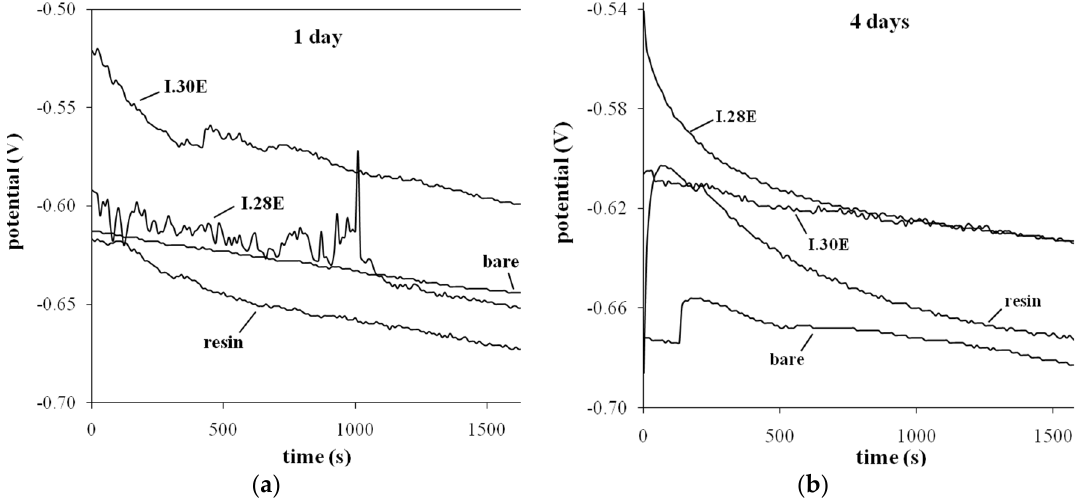
Figure 9. Open circuit potential measurements of all types of bare or coated specimens after 1 day ( a ) and 4 days ( b ) of exposure in a corrosive environment of 3.5 wt % NaCl solution.